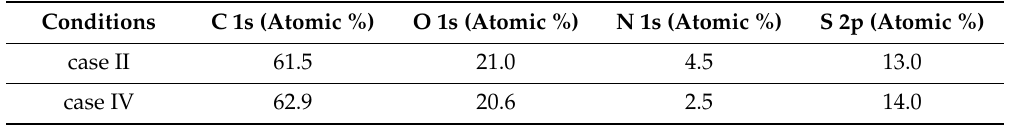
Figure 8. XPS survey spectra ( a ) and detailed high-resolutions with deconvolutions ( b – e ) of TAC films deposited on glass substrates by APPJs polymerization at blending condition of case IV (aniline 25% and thiophene 75%). Table 4. Elemental compositions of XPS for chemical structure of TAC films deposited on glass substrates by APPJs polymerization technique at two di ff erent blending conditions of cases II (aniline 75% and thiophene 25%) and IV (aniline 25% and thiophene